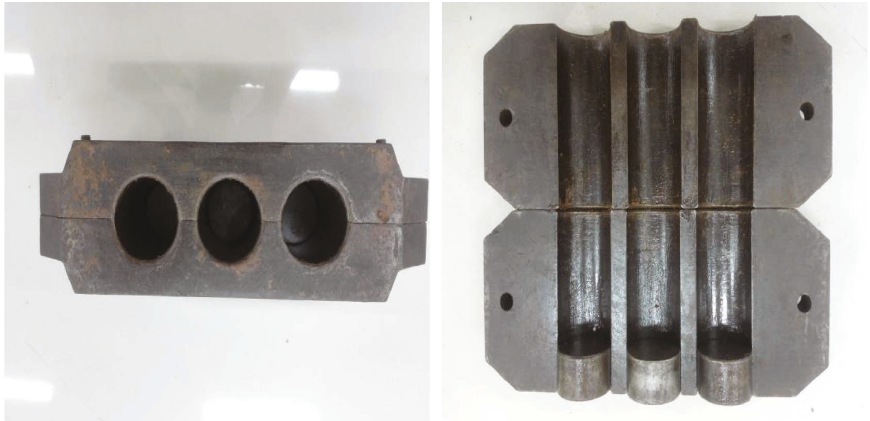
Figure 2: Test sample